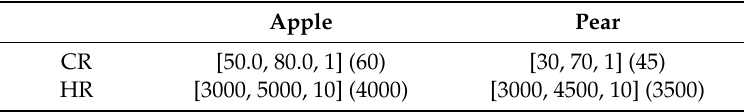
Table 2. Parameter space in squared brackets: Lower and upper bound and step; in round brackets: Initial guess (values approximated based on